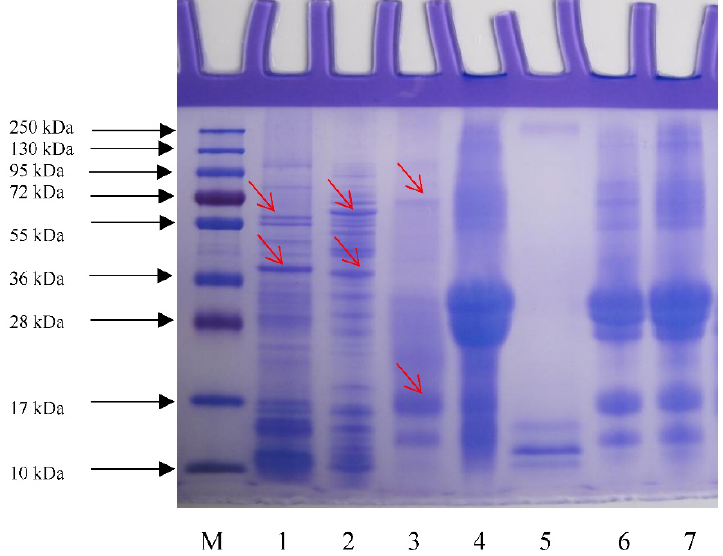
Figure 7. SDS - PAGE analysis of surface protein of samples extracted with LiCl solution. Samples: Figure 7. SDS-PAGE analysis of surface protein of samples extracted with LiCl solution.